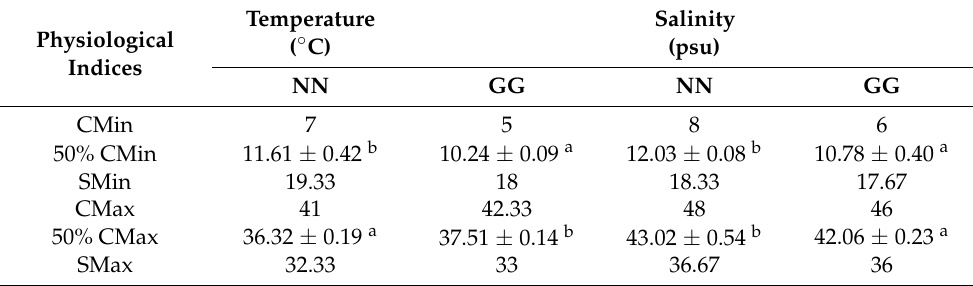
Figure 1. Comparison of accumulative survival rate (ASR) of C. nippona (NN) and C. gigas (GG) spat under constant changes (2 °C d −1 or 2 psu d −1 ) in (A, B) temperature and (C, D) salinity. Single asterisk indicates p < 0.05, double asterisk indicates p < 0.01. Table 1. Physiological indices of C. nippona and C. gigas spat under constant changes in temperature (2 °C d −1 ) and salinity (2 psu d −1 ).